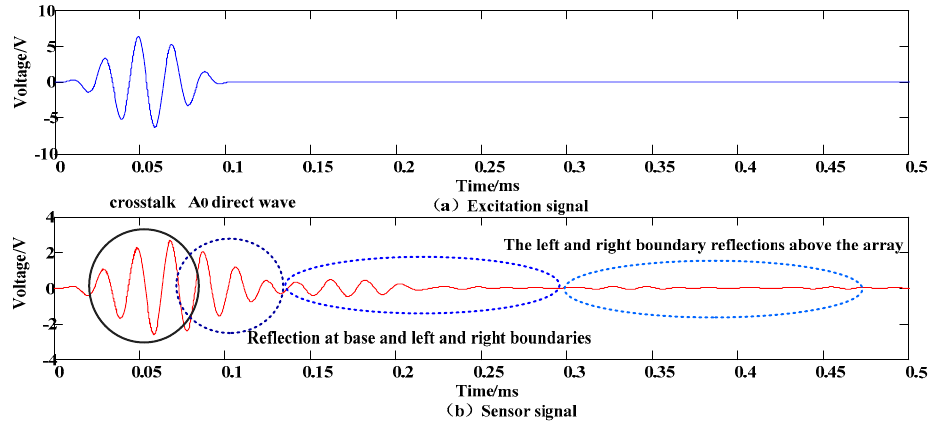
Figure 10. The excitation signal and the sensor signal.